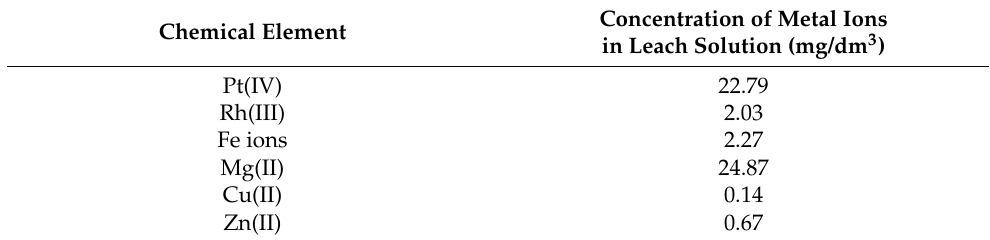
Table 5. Metal ion concentrations after leaching with HCl/H 2 O 2 /H 2 SO 4 (S/L = 1/100 g/cm 3 , 3 h, 70 ◦ C, 300 rpm)